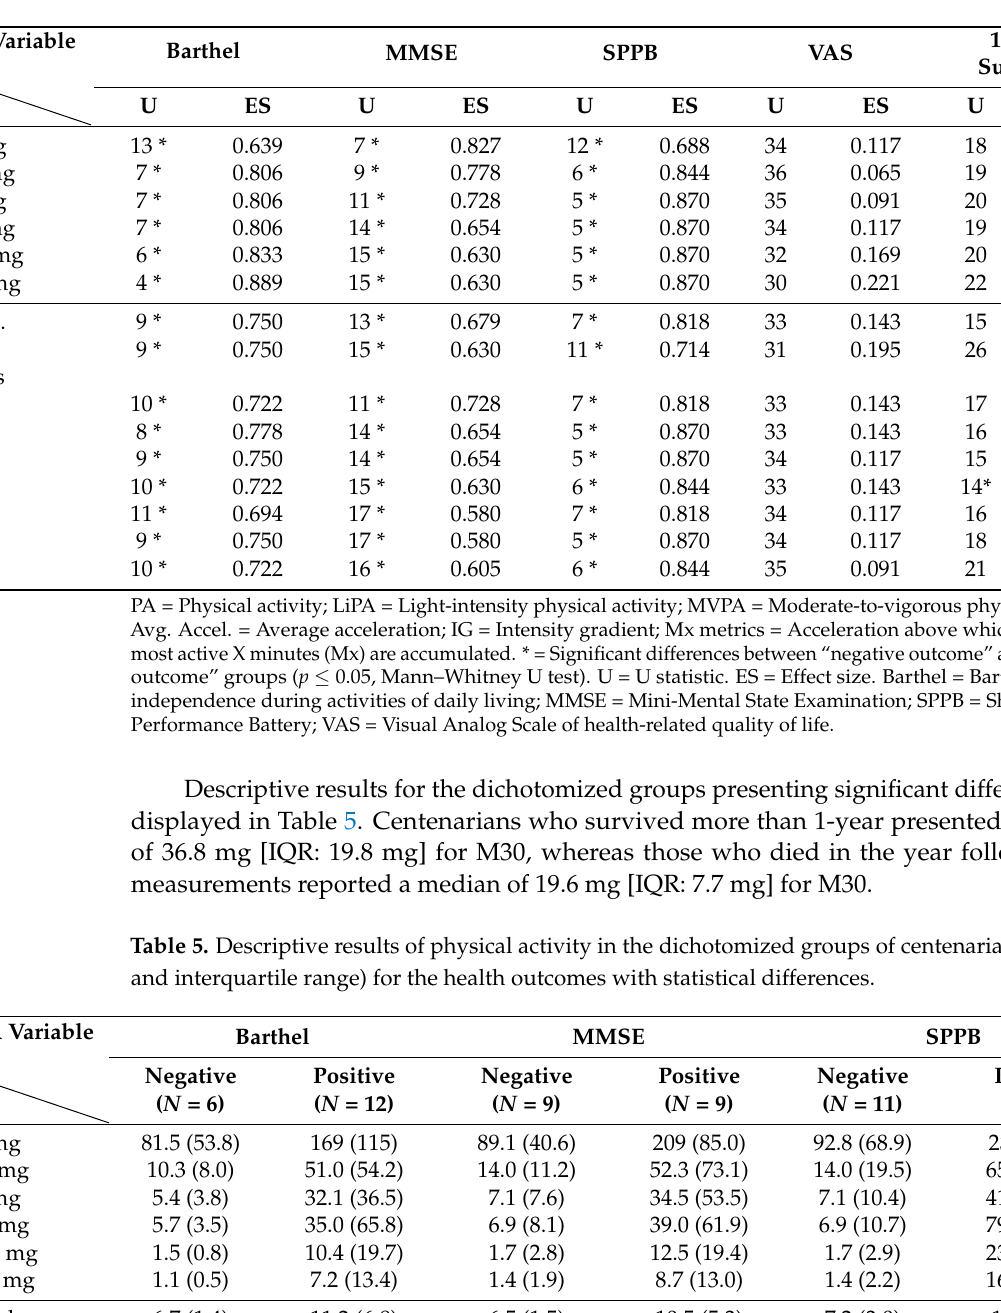
Table 4. Differences in physical activity variables between dichotomous groups for different health outcomes.